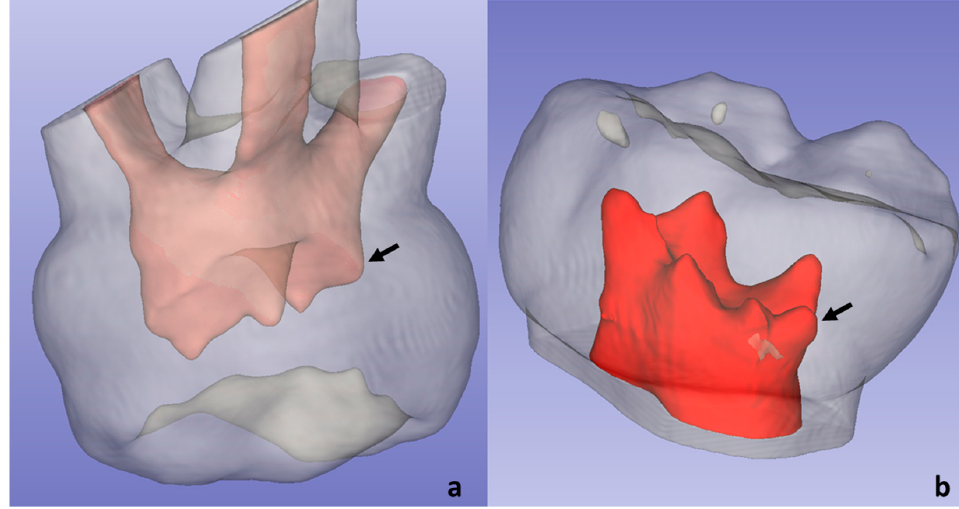
Figure 11. The arrows indicate the accessory pulp horns in P1MS ( a ) and P2MI ( b ). The hyperdense images, compatible with the pulp stone observed and that could be reconstructed in three dimensions, had a frequency in the P1MS of five (18.52%), of which, two (7.41%) were located in the coronal third, and three (11.11%) in the middle third. In the P1MI, two (6.90%) images were visualised, both located in the middle coronal third. In the P2MS, three (13.64%) were observed, two of them in the coronal third (9.09%) and one in the cervical third (4.55%). Finally, in the P2MI, two images were detected in the middle third (7.69%) (Figure 12).